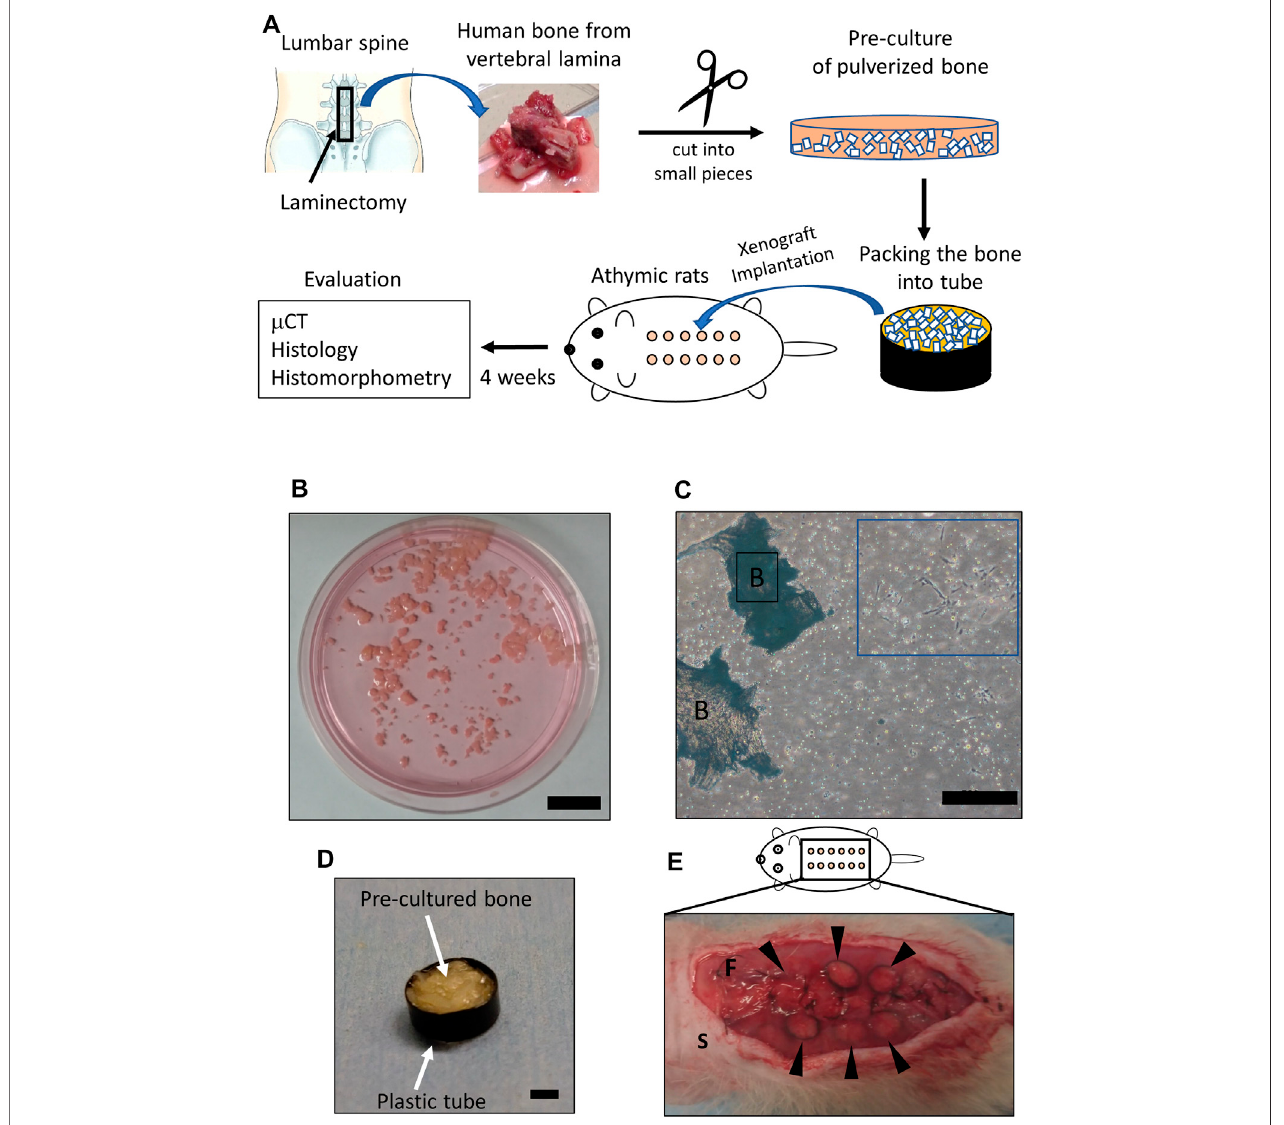
FIGURE 1 | Details of the xenograft model. (A) Scheme showing the protocol of the xenograft model. The square indicates the area where vertebral bone was obtained (upper left). Bone of vertebral lamina (upper center) was pulverized into small pieces ( ≤ 1 mm) (upper right) and pre-cultured for 2 weeks. Twelve xenograft samples(circlescoloredinorange)wereimplantedunderneaththedorsalfascia(lowercenter).Evaluationswereperformed4weeksafterimplantation. (B) Pre-cultureof pulverized bone in medium. Scale bar, 2 mm. (C) Human cells observed 2 weeks after pre-culture (blue square). Scale bars, 500 μ m. B, bone. (D)